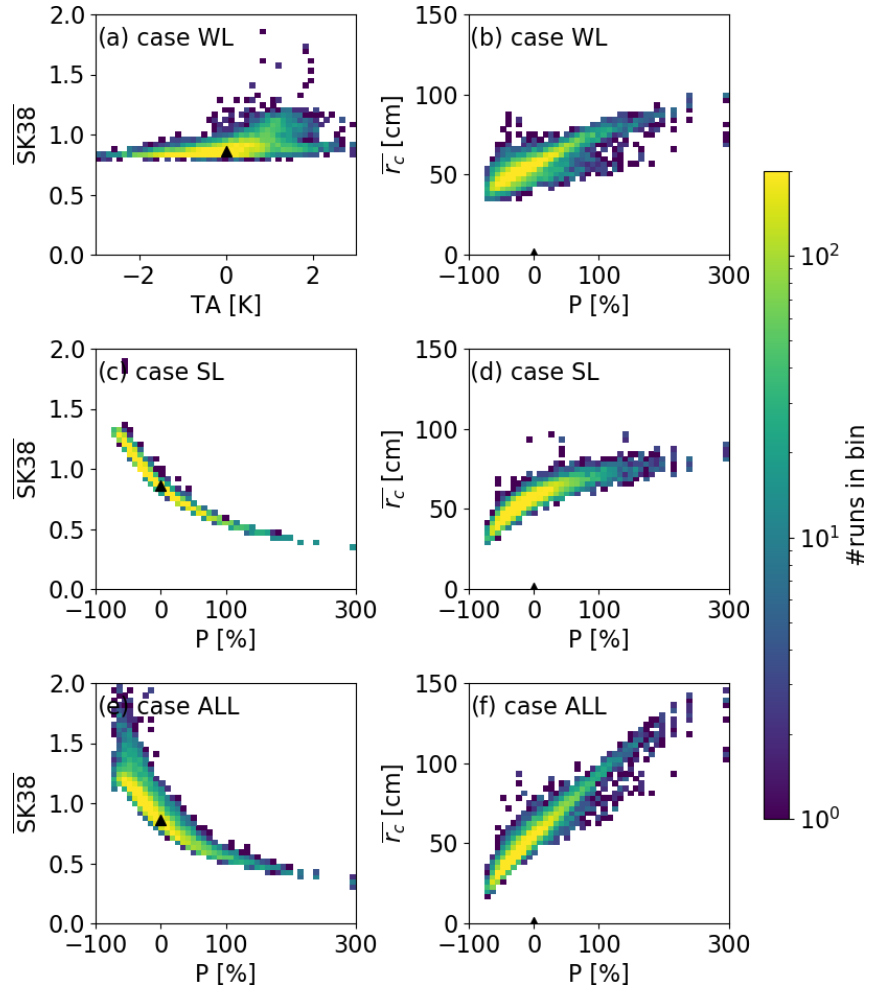
Figure 10. Modeled (a, c, e) SK38 and (b, d, f) r c with uncertainty in the most sensitive input parameters, i.e., air temperature (TA) and precipitation ( P ), on 9 March 2017 for (a, b) case WL, (c, d) case SL and (e, f) case ALL. Colors indicate the number of simulations in each of the 50 × 50 bins. Triangles indicate the reference